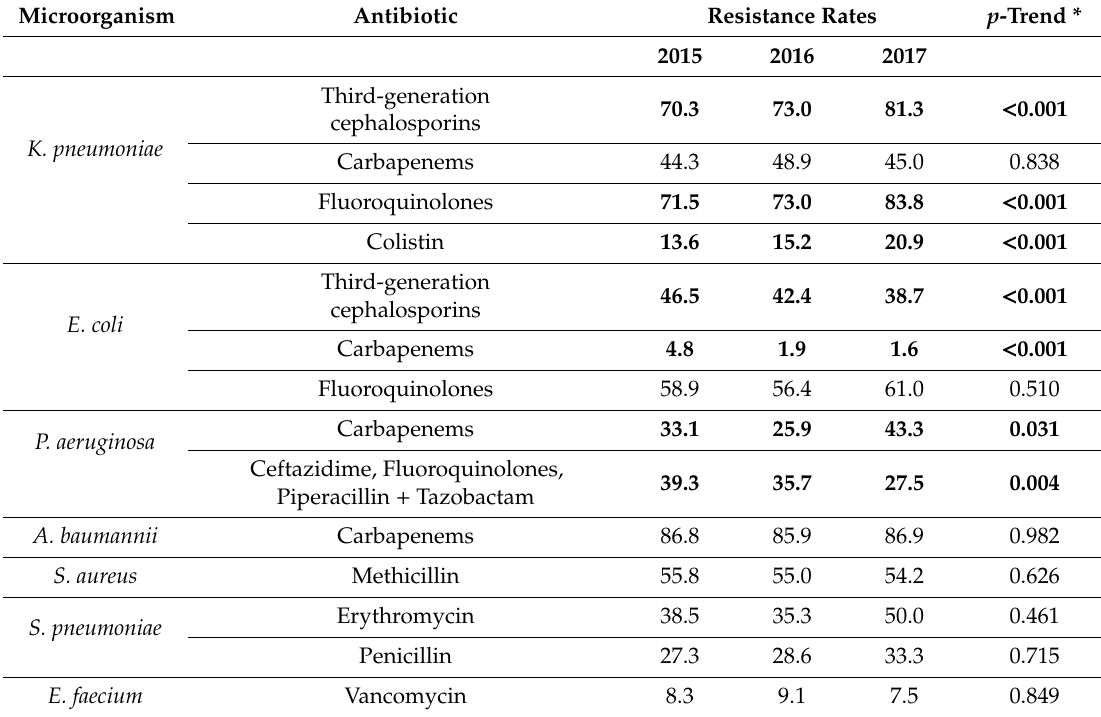
Table 2. Resistance rates of included microorganisms during the three-year period (2015–2017).